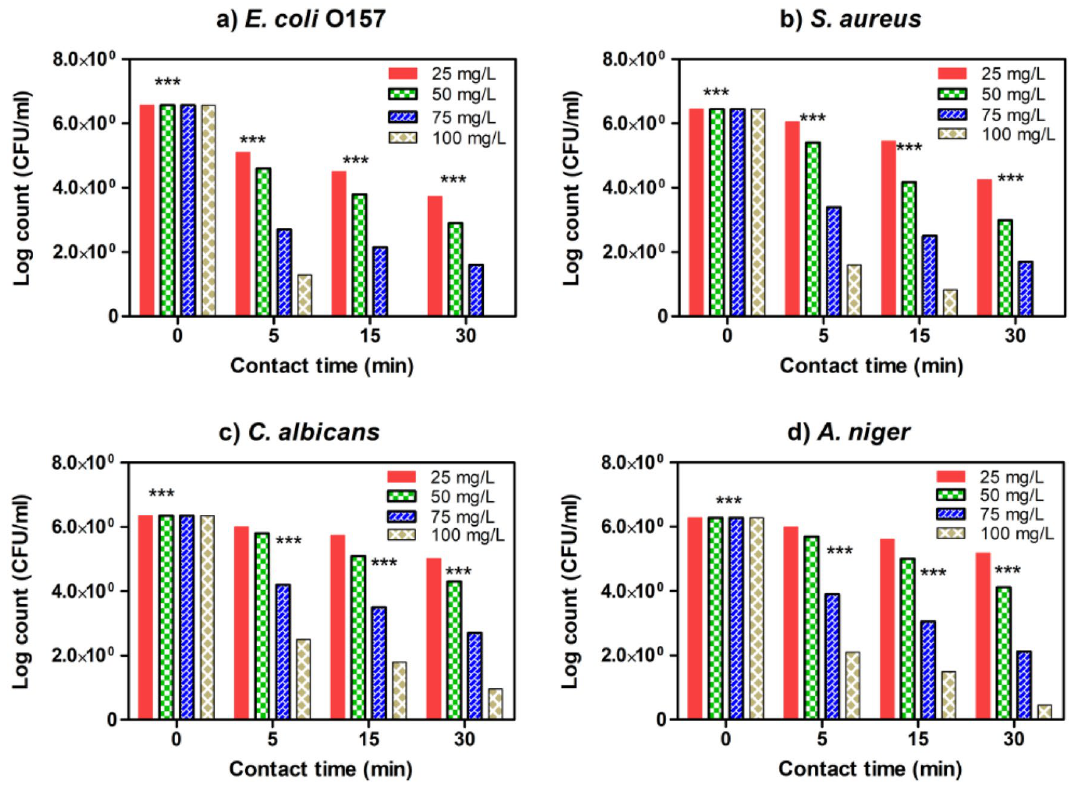
Figure 9. Estimated MIC values of SMZC-0.3Ni towards four tested microbial species, including ( a ) E. coli , ( b ) S. aureus , ( c ) C. albicans , and ( d ) A. niger . The remaining viable cell populations at various time intervals of 5, 15, and 30 min are also